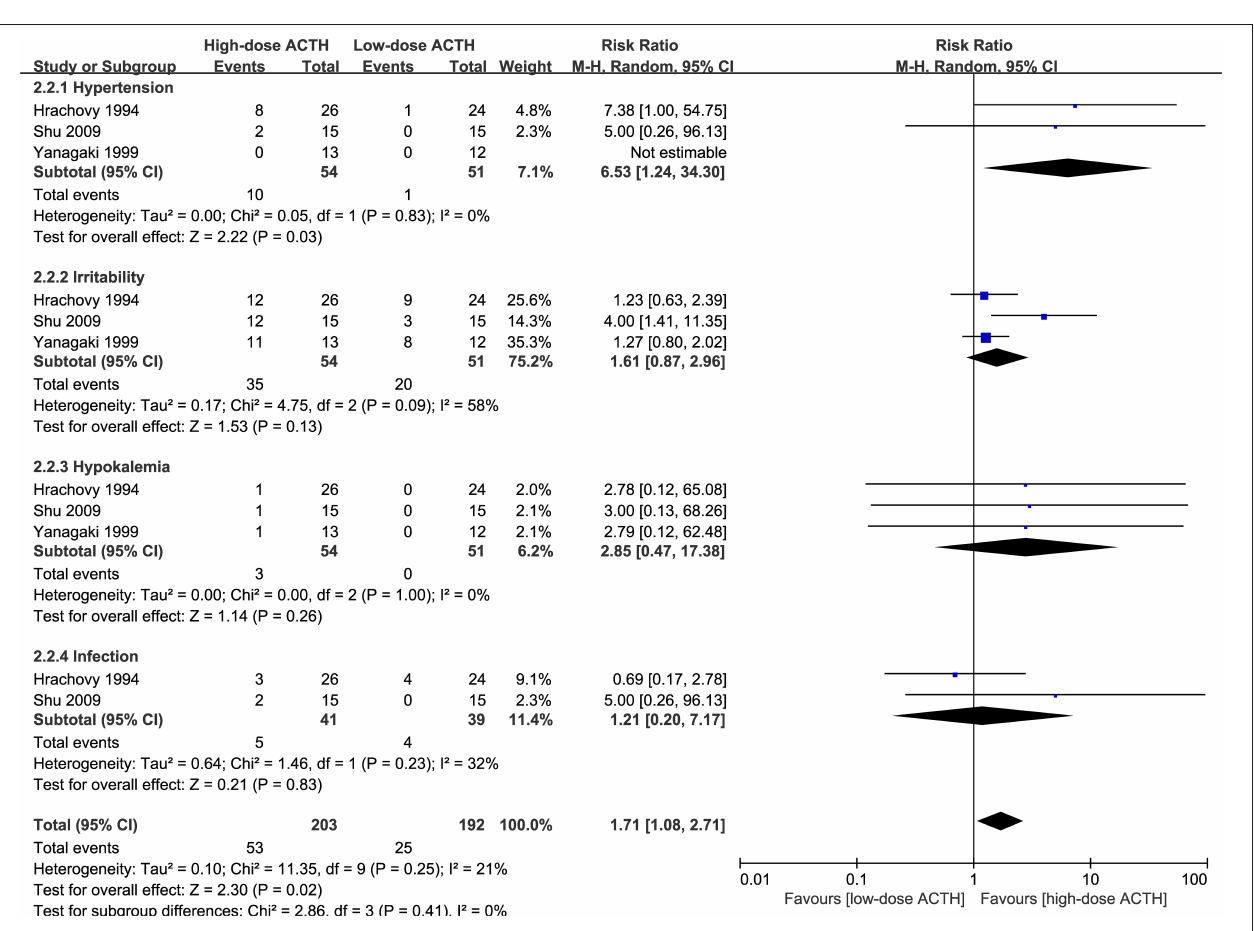
FIGURE 5 | Forest plot showing RR and 95% CI of adverse effects between high and low dose of